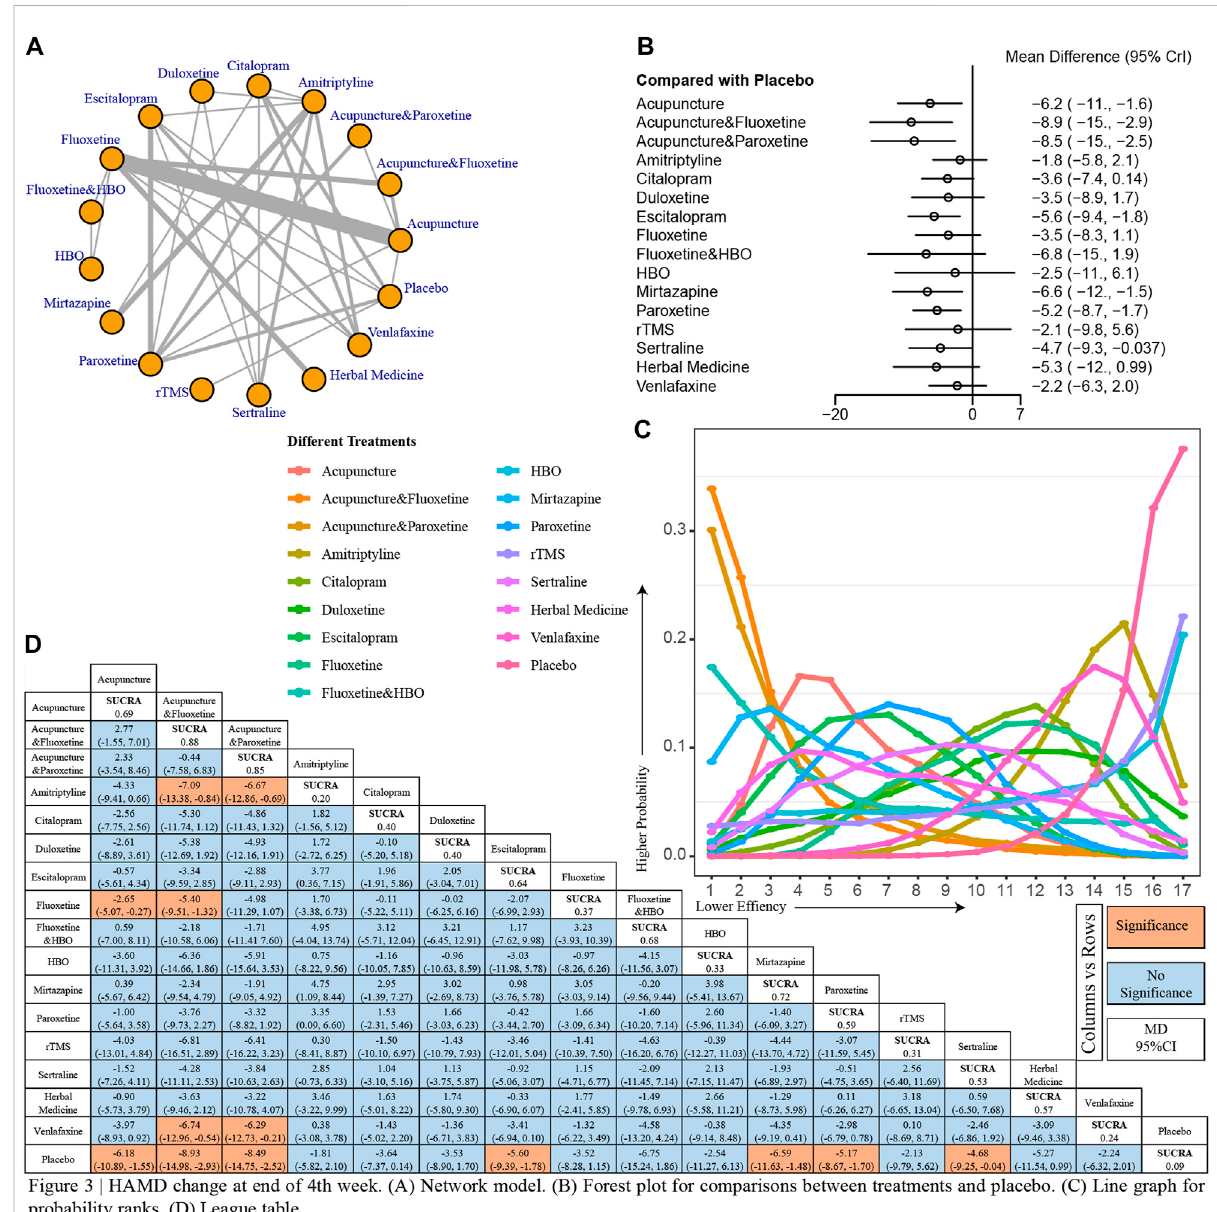
I HAMD change at end of 4th week. (A) Network model. (B) Forest plot for comparisons between treatments and placebo. (C) Line graph for probability ranks. (D) League